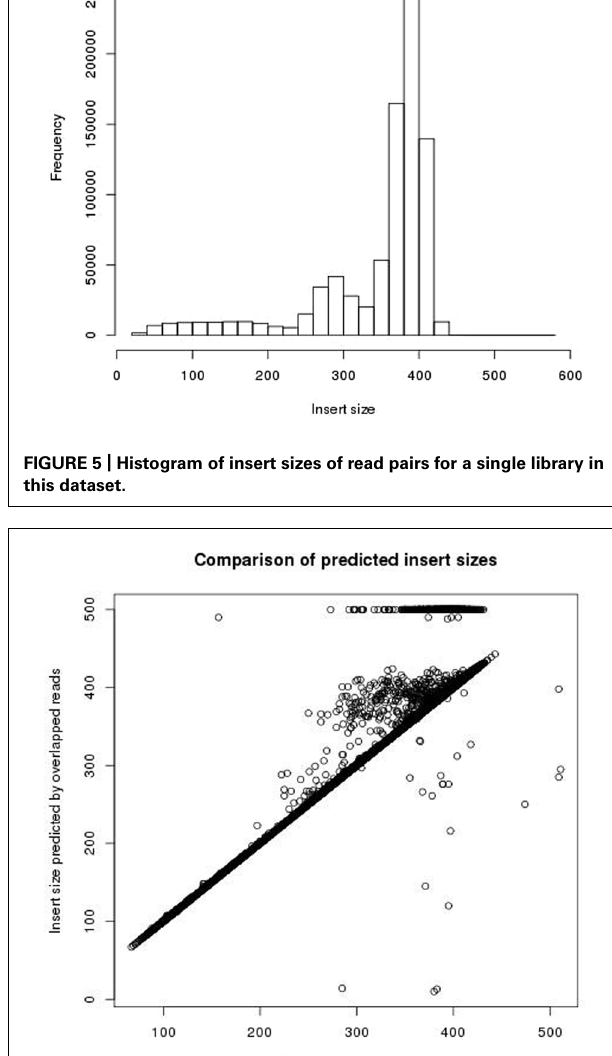
all the way through the adapter, a run of As is seen followed by apparently random sequence. Figure 7A shows the plot that would be expected if the extracted sequence was purely the expected